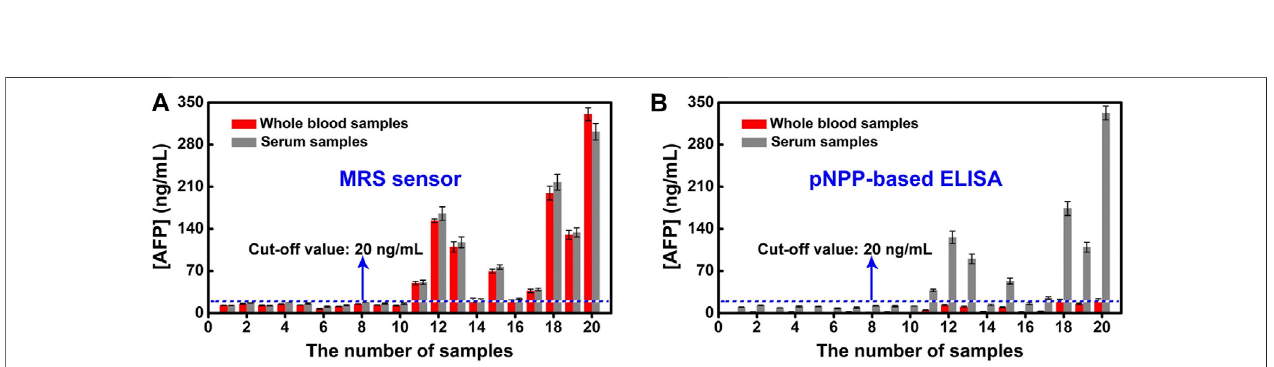
FIGURE 7 | (A) Correlation between the detection of AFP in whole blood samples and serum samples by MRS sensor. (B) Correlation between the detection of AFP in whole blood samples and serum samples by the pNPP-based ELISA.